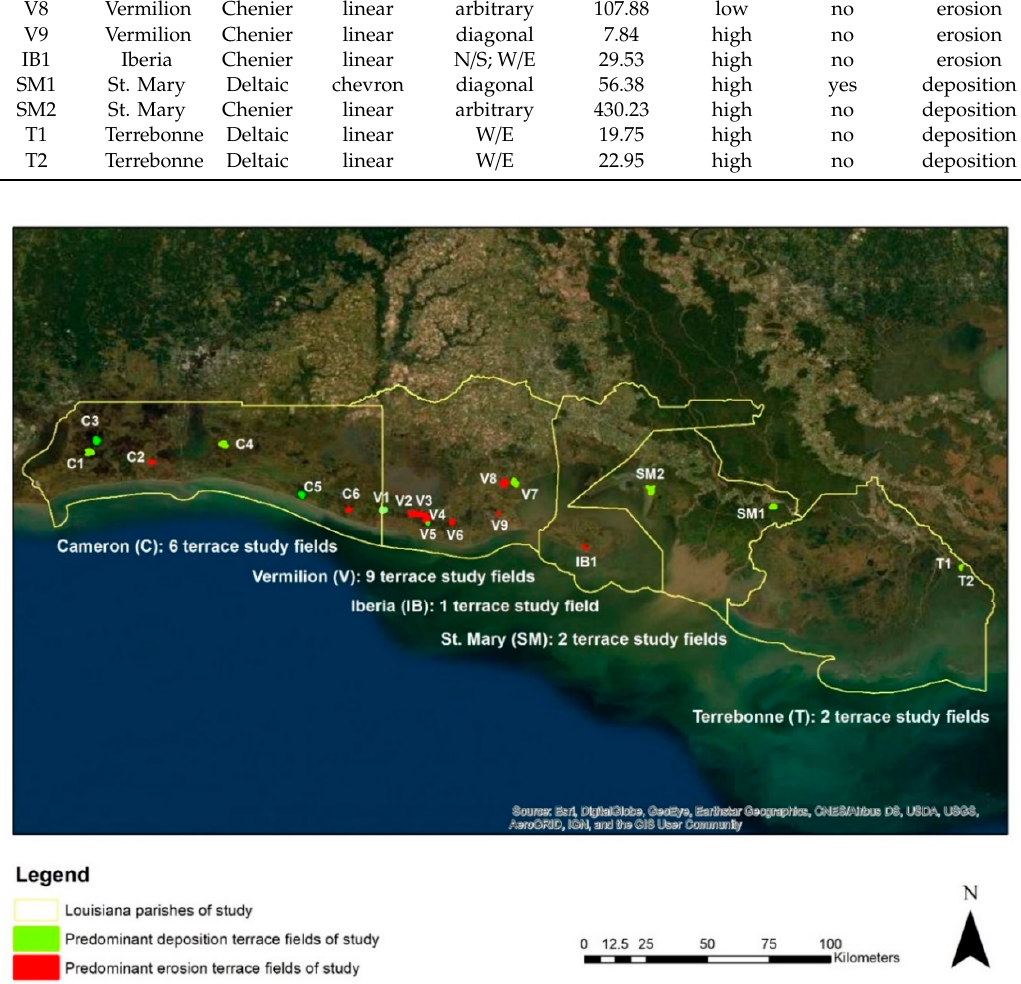
Figure 4. Marsh terrace fields of study performance over time in the Chenier Plain and Deltaic Plain Region in Coastal Louisiana. T1 and T2 are Region in Coastal Louisiana. T1 and T2 are overlapping.